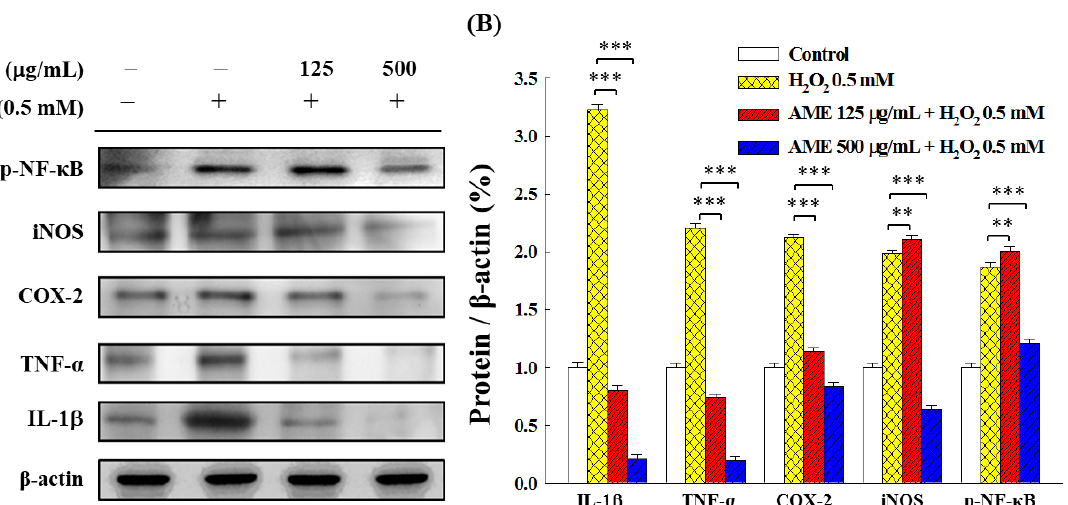
Figure 10. Effect of AME pretreatment on the ROS generation in H 2 O 2 -stimulated PC12 cells. ( A ) The intracellular ROS levels indicated by DCF-DA fluorescence intensity. ( B ) Fluorescent quantitation. This experiment was repeated three times. The significance of the difference in data compared to the vehicle (group 0) is labeled as *** p < 0.001.